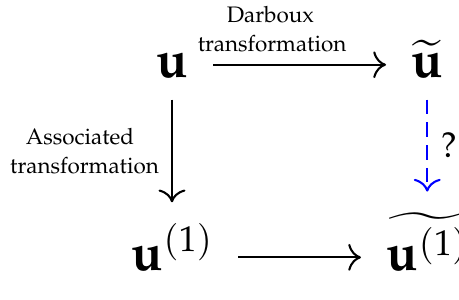
Figure 2. Structure of Problem